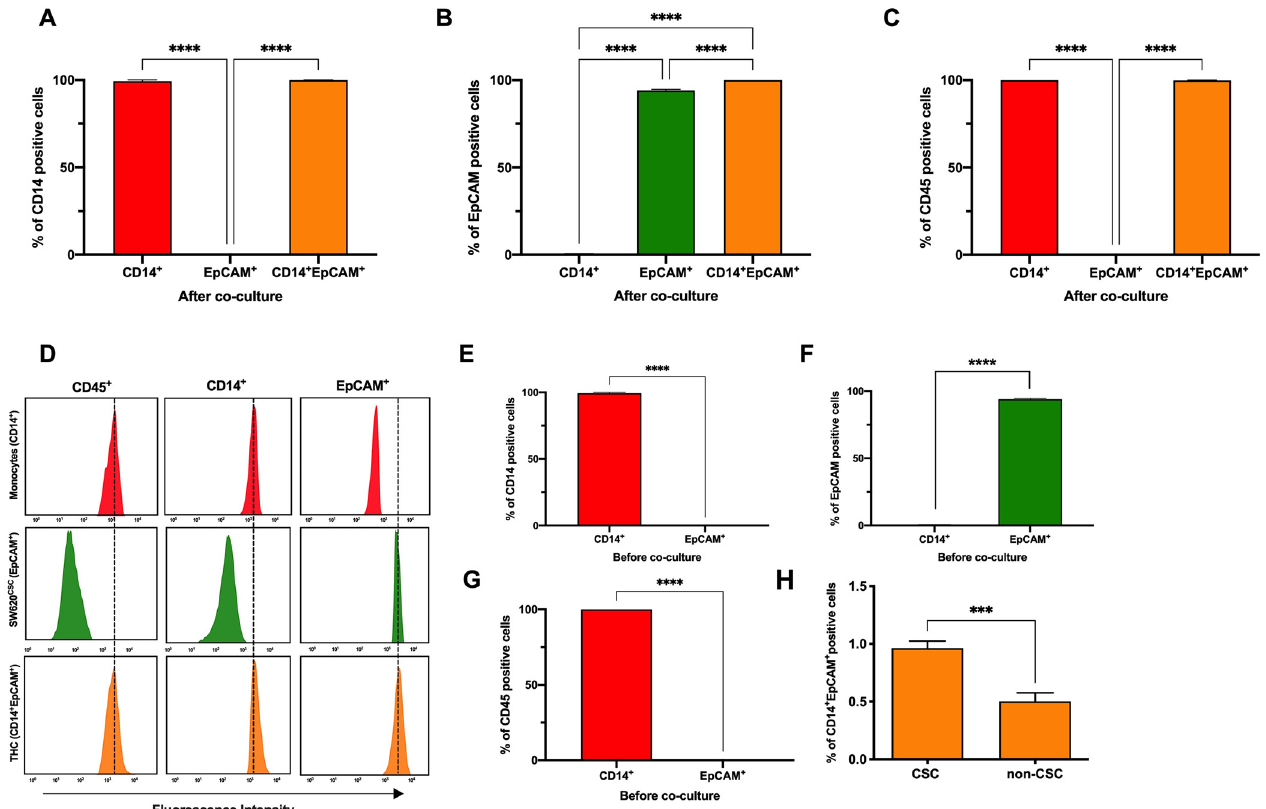
Figure 2. Characterisation of novel resulted THCs after co-culture. Analysis of expression of ( A ) CD14, ( B ) EpCAM and ( C ) CD45 on CD14 + human monocytes (red), EpCAM + SW620 CSC (green) and on CD14 + EpCAM + THCs (tangerine) after 5-day co-culture by FACS (n = 3). ****, p < 0.0001 in one-way ANOVA with Tukey’s multiple comparison post-hoc test. ( D ) Representative histogram of CD45, CD14 and EpCAM fluorescence intensity in monocytes (red), SW620 CSC (green) and THCs (tangerine) after 5-day co-culture. ( E ) Analysis of CD14 expression on CD14 + human monocytes (red) and EpCAM + SW620 CSC (green) before co-culture by FACS. ( F ) Analysis of EpCAM expression on CD14 + human monocytes (red) and EpCAM + SW620 CSC (green) before co-culture by FACS. ( G ) Analysis of CD45 expression on CD14 + human monocytes (red) and EpCAM + SW620 CSC (green) before co-culture by FACS. ( H ) Percentage of CD14 + EpCAM + -positive cells after 5-day co-culture with SW620 CSC and SW620 cells. n = 3; ***, p < 0.001; and ****, p < 0.0001 in unpaired t -test.